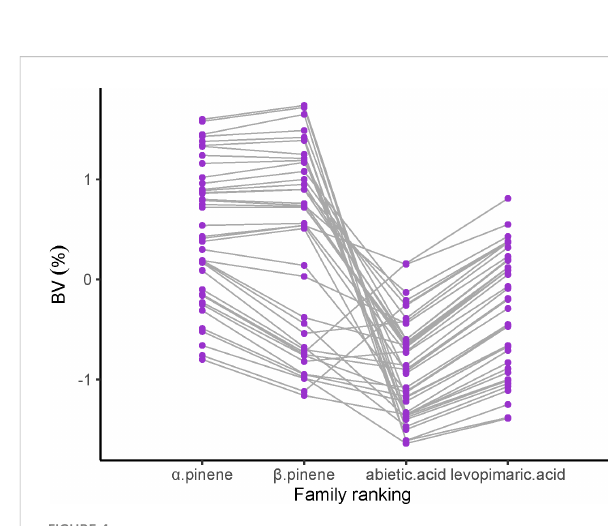
FIGURE 4 Fifty-nine families rankings for breeding value (BV) of the a pinene, b pinene, abietic acid and levoprimaric acid in slash pine at age 29. Each purple dot and gray line represent one family.